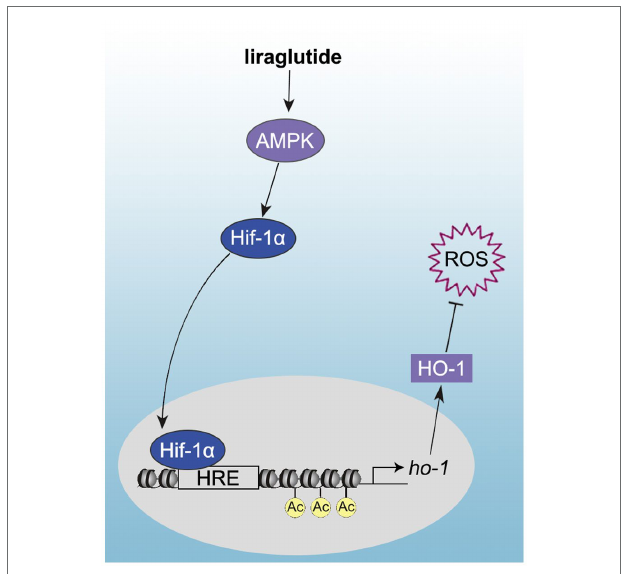
FIGURE 6 | Schematic showing that the promotion of diabetic wound healing by Lira occurs via its AMPK-dependent endothelial protection and pro-angiogenic effects, which are regulated by the Hif-1 α –HO-1